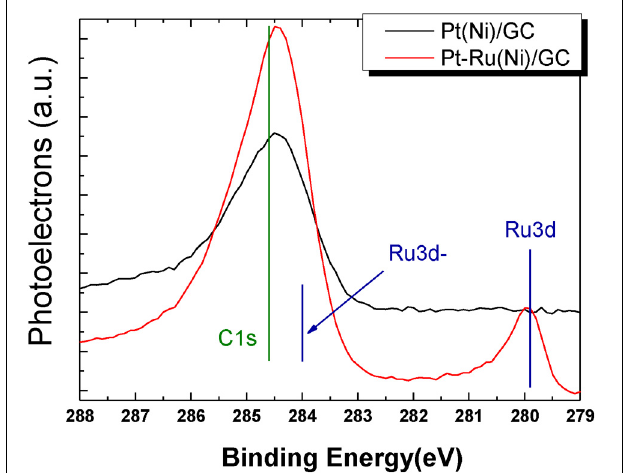
FIGURE 3 | XPS spectra in the Ni2p binding energy range for Pt(Ni) (upper curve) and Pt-Ru(Ni) (lower curve) coatings. FIGURE 4 | XPS spectra in the C1s and Ru3d binding energy range for Pt(Ni) (upper curve) and Pt-Ru(Ni) coatings (lower curve).